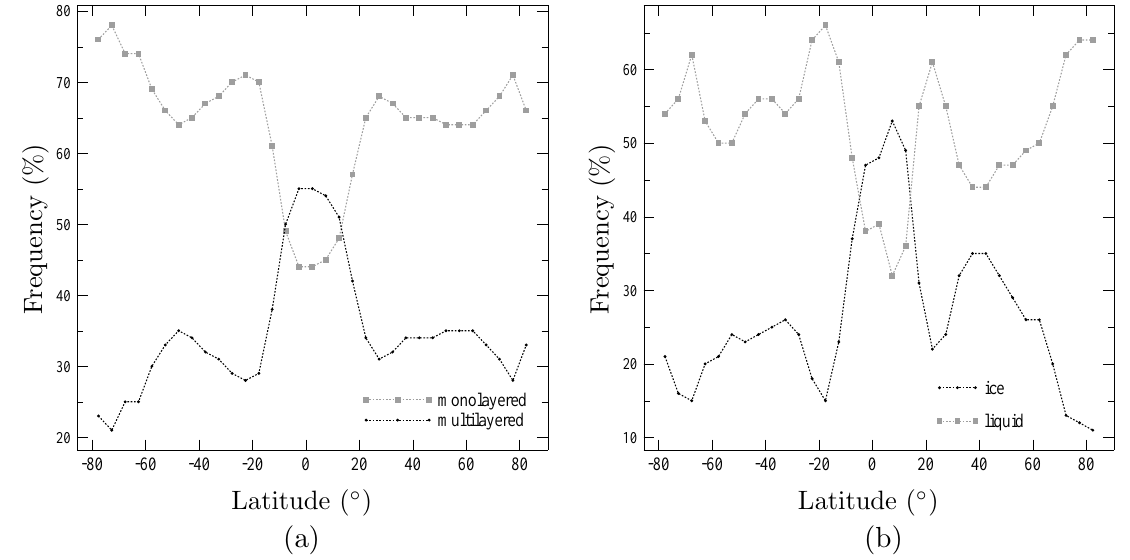
Fig. 3. Climatology of monolayered vs. multilayered clouds in 2008 from the 2B-GEOPROF-LIDAR product. (a) provides the zonal occur- rences in percent of monolayered (grey line) and multilayered (black line) clouds. (b) provides the zonal occurrences in % of liquid water (grey line) and ice (black line) clouds among monolayered clouds (the thermodynamical phase comes from PARASOL and MODIS).